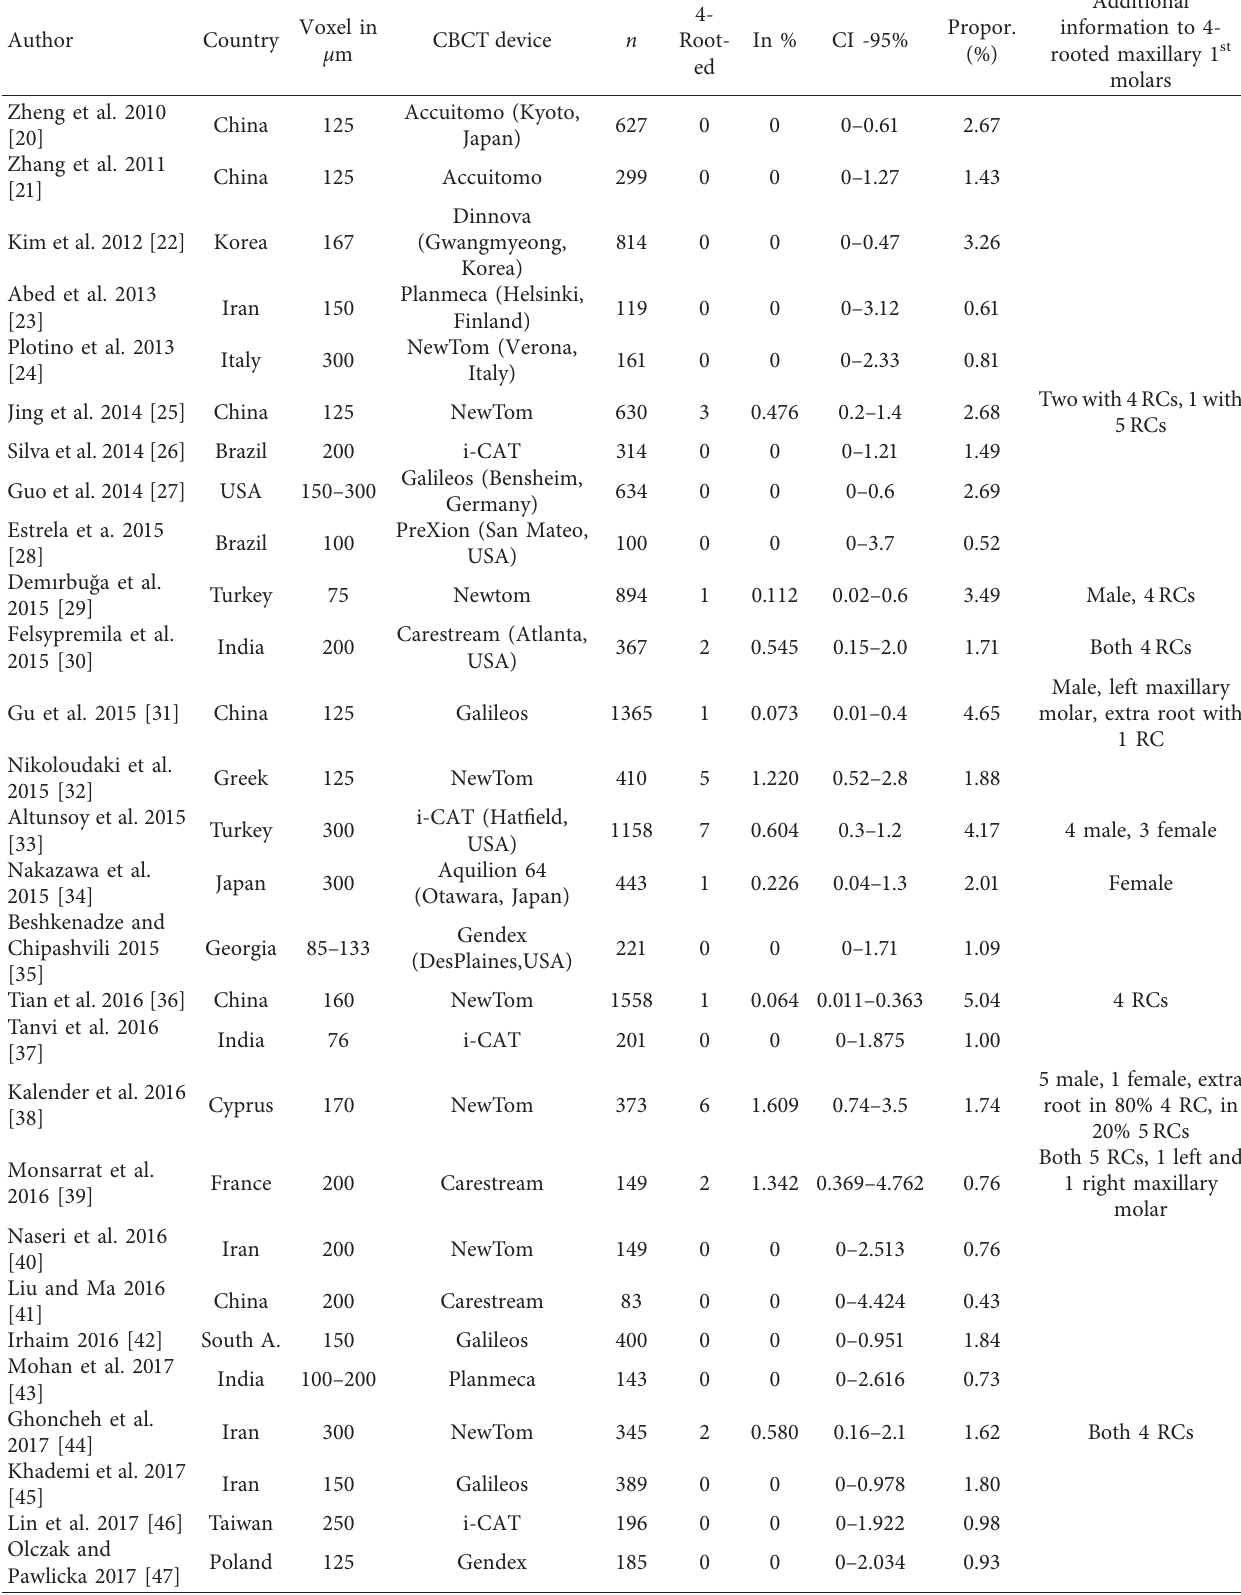
Table 1: Analysis of the population-based CBCT